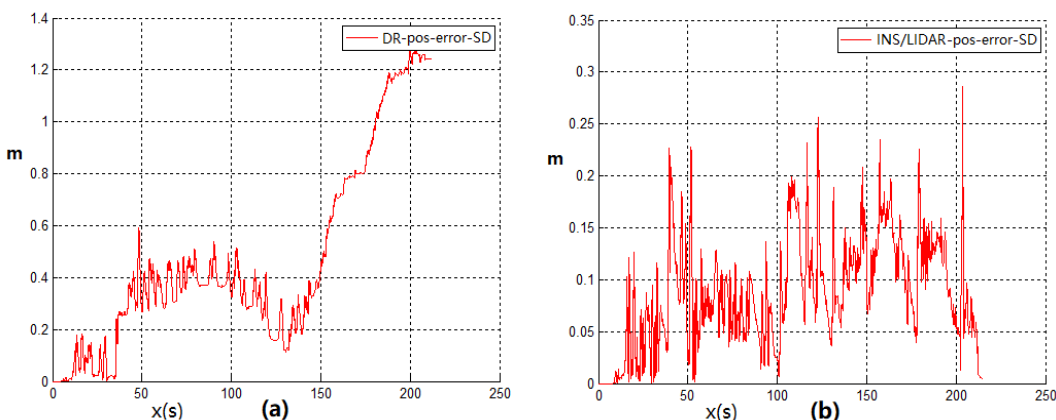
Figure 8. The comparison Standard Deviation (SD) error graph of the integrated navigation algorithm (the first part of experiment 2). ( a ) The DR algorithm trajectory error ( b ) The INS/LIDAR algorithm trajectory error.